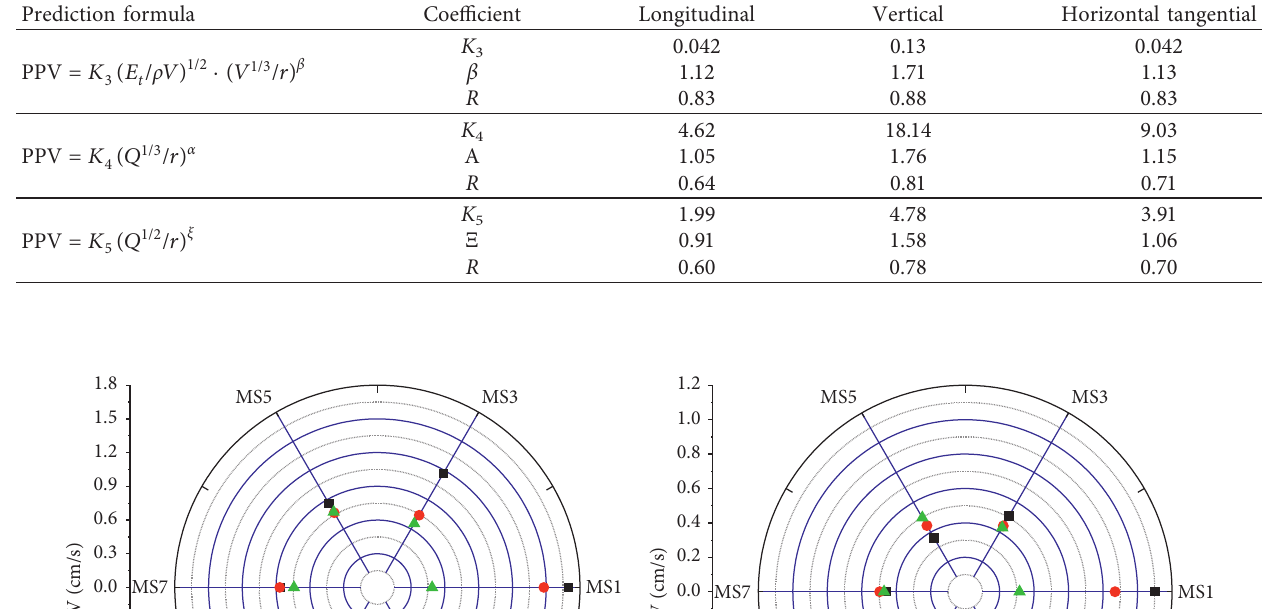
Table 3: Unknown coefficients and correlation coefficients in equations (32), (39), and (40).